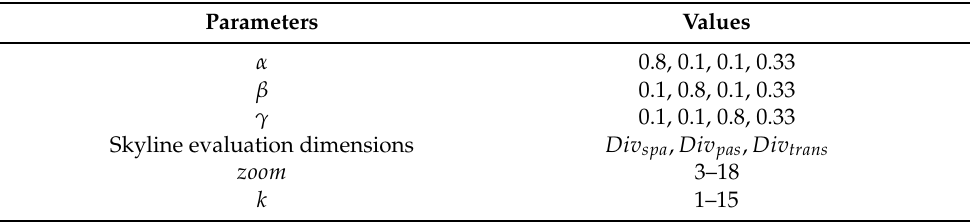
Table 3. Parameters and